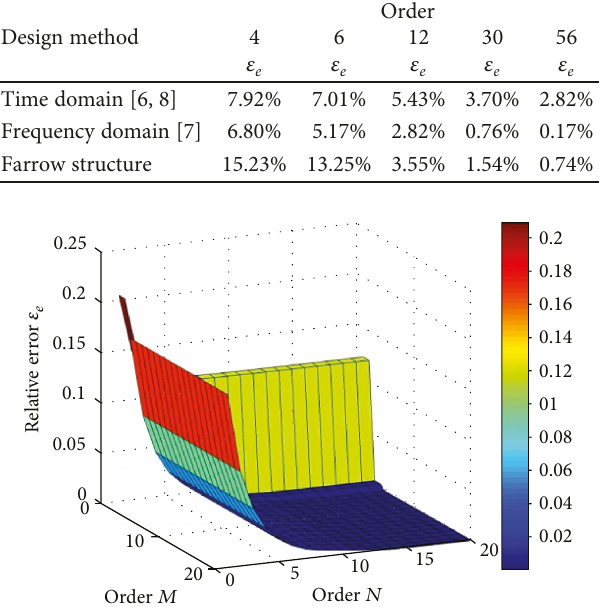
Table 1: Relative error with di ff erent fi lter orders. Design method